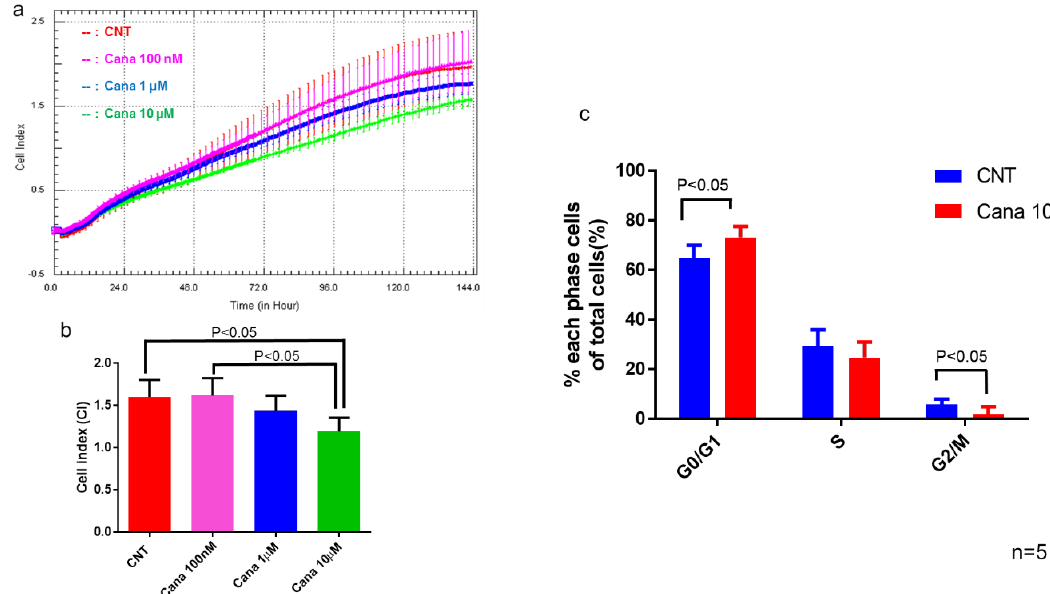
Figure 7. Canagliflozin at a concentration of 10 µ M attenuated cell proliferation of HepG2 cells and induce cell cycle arrest. ( a ) Real-time analysis of cell proliferation of HepG2 cells in a dose-dependent manner. ( b ) Treatment with 10 µ M canagliflozin inhibited HepG2 cell proliferation when compared with the control or 100 nM canagliflozin. ( c ) Canagliflozin inhibits G2 / M cell cycle progression of HepG2 cells.